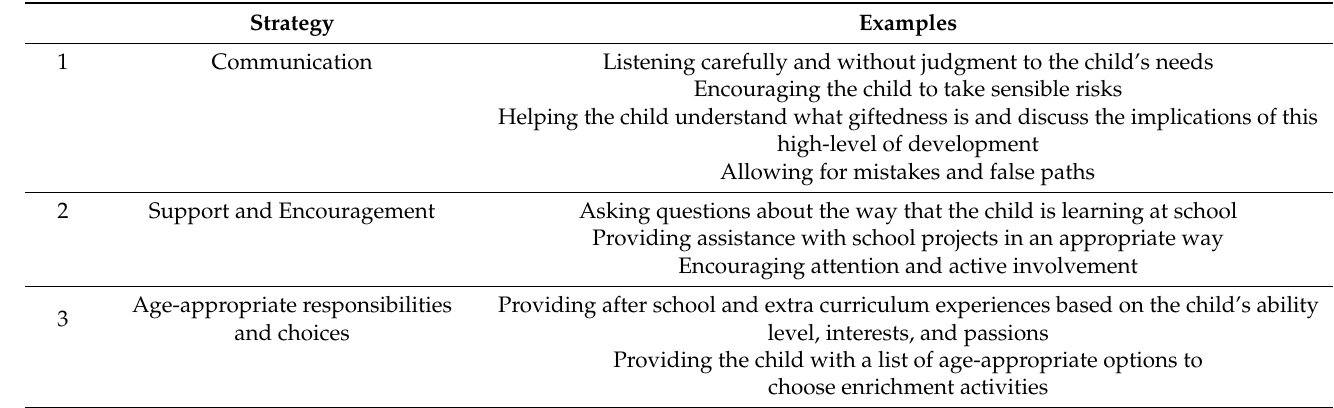
Table 3. Parenting strategies for helping G/T